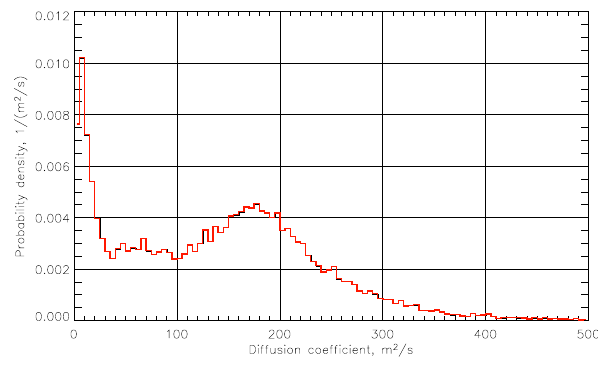
Fig. 16. Histogram for diffusion coefficient data presented in this